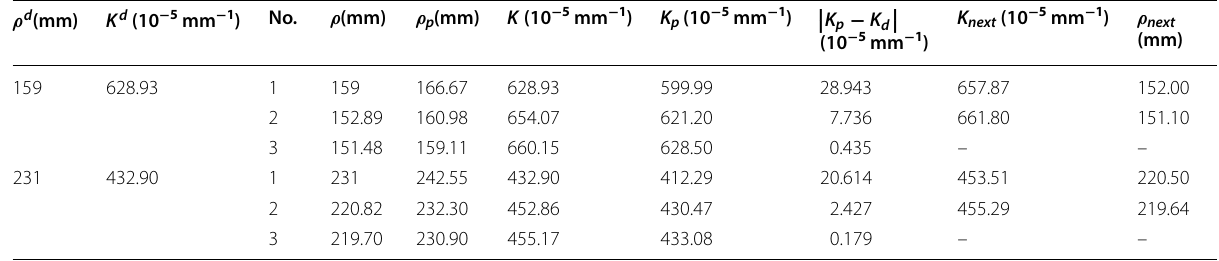
Table 4 The iterative compensation process of curvature in stretch‑bending ρ d